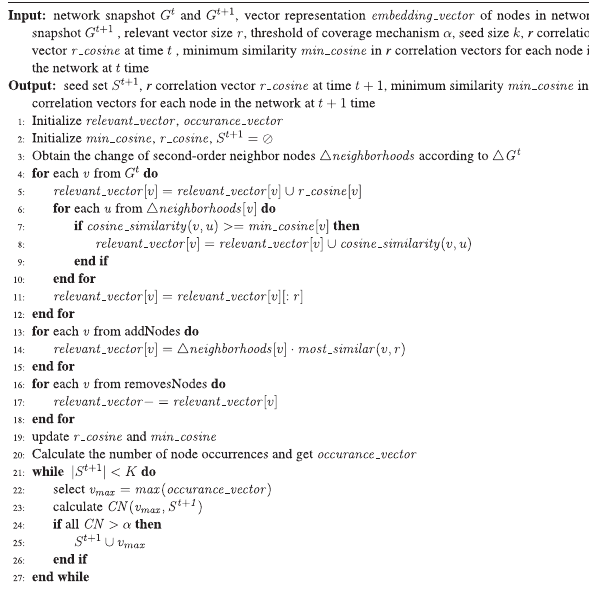
Algorithm 2. Seed set incremental